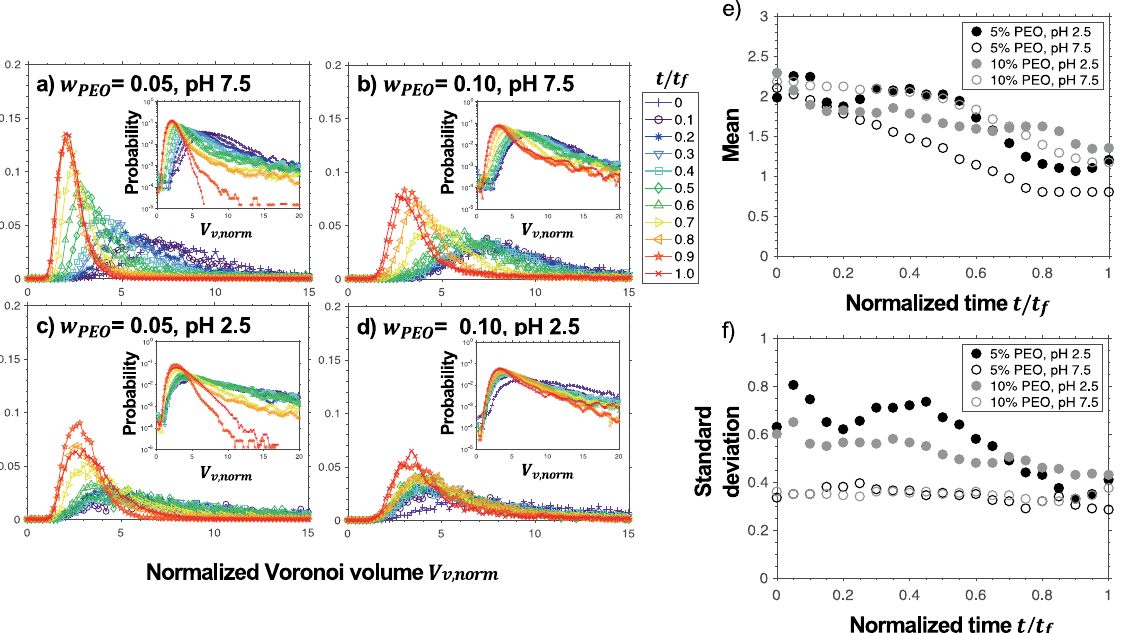
Figure 6. Normalized Voronoi volume, V v,norm , distribution of SiO 2 in the SiO 2 -PEO mixtures while drying, 0 < t/t f < 1. The mixtures consist of φ 0 = 0.05 and ( a ) w PEO = 0.05 at pH 7.5, ( b ) w PEO = 0.10 at pH 7.5, ( c ) w PEO = 0.05 at pH 2.5, and ( d ) w PEO = 0.10 at pH 2.5. Insets show the same data plotted as a log-linear plot which is best fitted with lognormal distribution function, giving fitting parameters ( e ) mean, μ , and ( f ) standard deviation, σ , as a function of normalized drying time t/t f